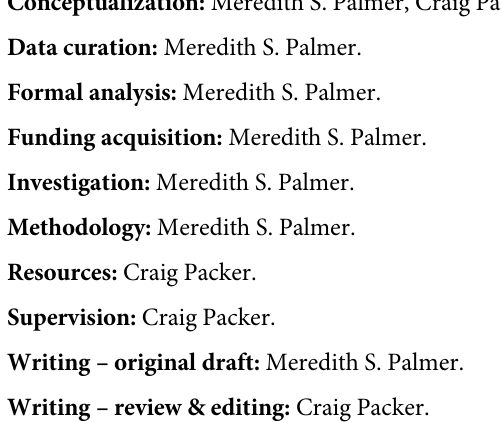
S9 Table. Intensity of response. Post-hoc interaction analysis of GLMM results from S6 Table using package ‘emmeans’ [83], evaluating the pairwise differences between species